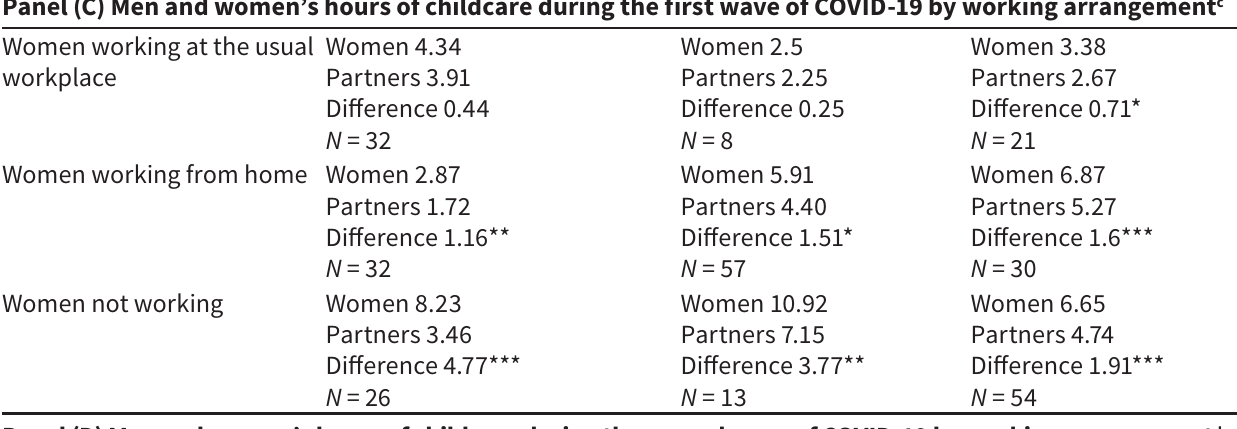
Panel (C) Men and women’s hours of childcare during the first wave of COVID-19 by working arrangement c